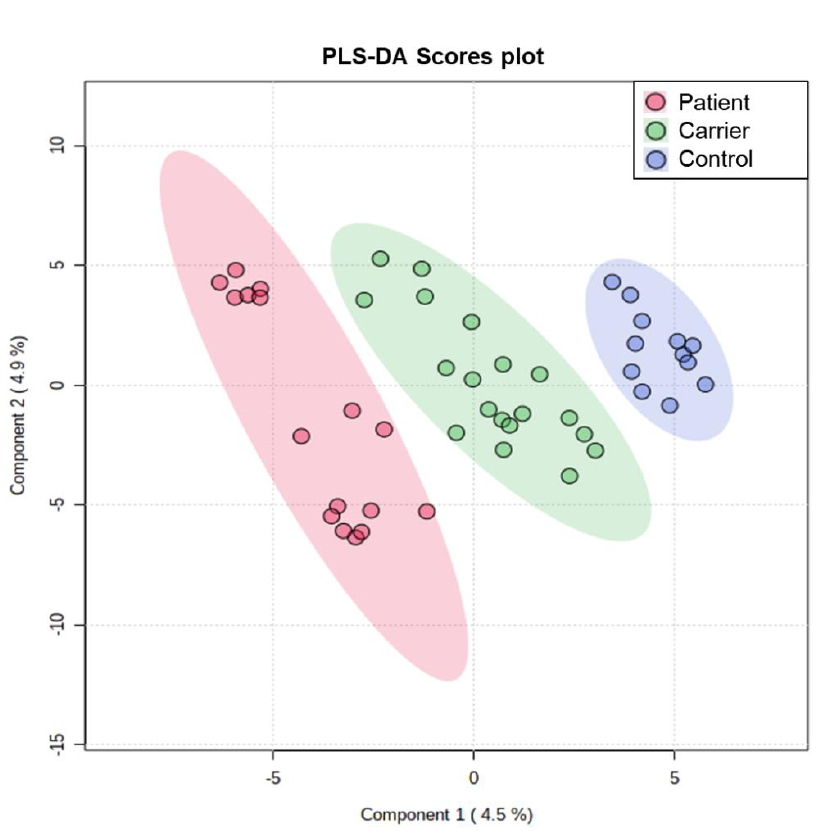
Figure 4. Partial least square-discriminant analysis (PLS-DA). Sample distributions around Principal Components (PC) 1 and 2 are shown. PC1 and PC2 explain 4.5% and 4.9% of the variance, respectively. Despite the recognized influence of biologic variability on the erythrocyte metabolome partial least square discriminant analysis shows that metabolic variance is explained by PKAN. The upper, slightly separate group of data is the sample set of the twin brothers with the T528M/G521R PANK2